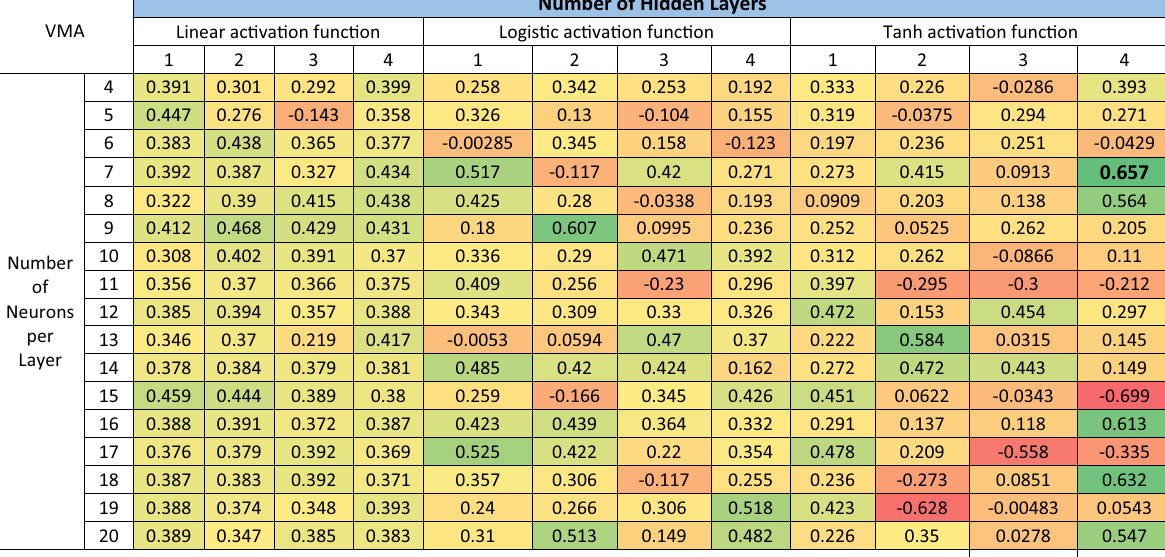
Number of Hidden